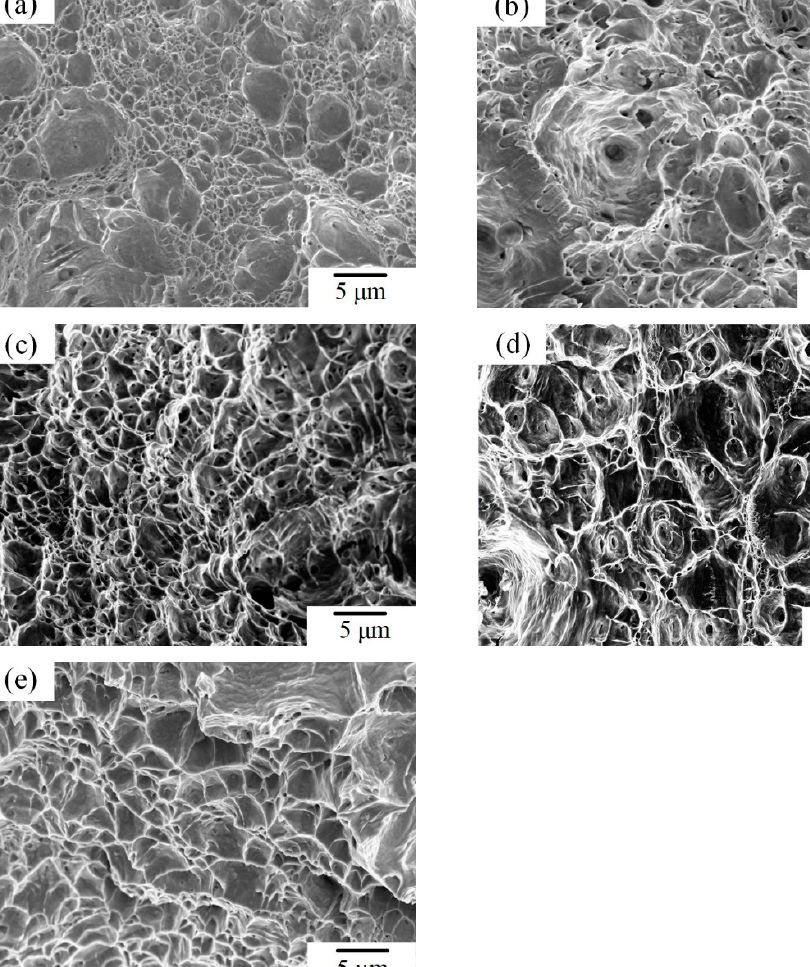
Figure 9. SEM image of tensile fracture. ( a ) BM. Welded joints under different welding speeds (mm/min): ( b ) 280, ( c ) 300, ( d ) 320, and ( e ) 340.